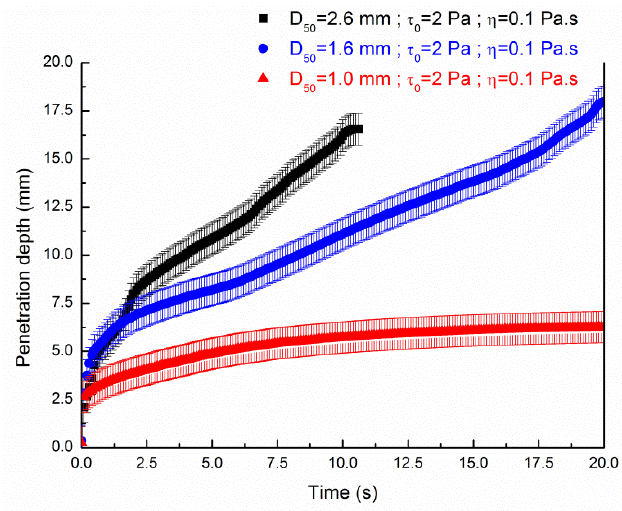
Figure 9. Influence of the average diameter of the sand bed particles on the penetration depth of a cement paste ( τ 0, exp = 2 Pa; η exp = 0.1 Pa · s ) of 20 mm height as a function of time.